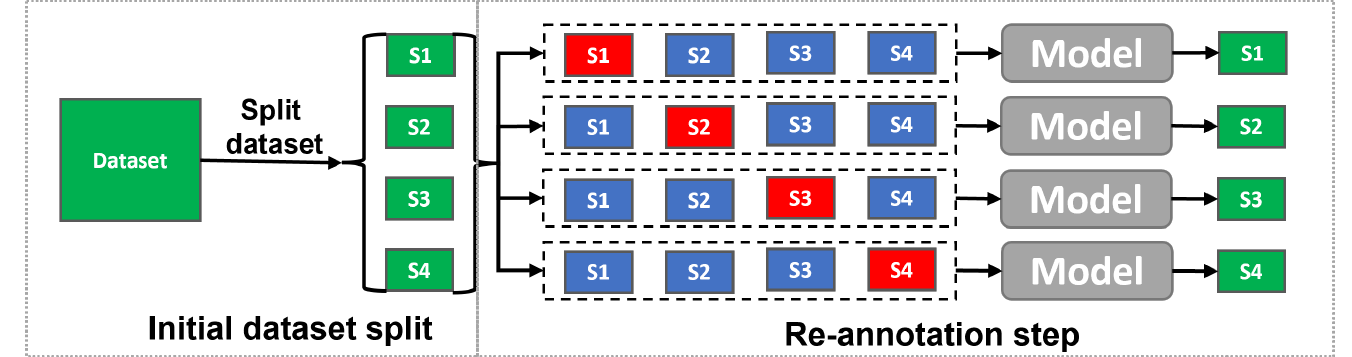
Figure 3. An example of a single re-annotations step. For the sake of this example, we split the dataset into 4 sets, and, for each model, we choose 1 set to be re-annotated while the others are used to train the model. At the end of the re-annotation stage, the entire dataset is re-annotated. The re-annotation step can be repeated multiple